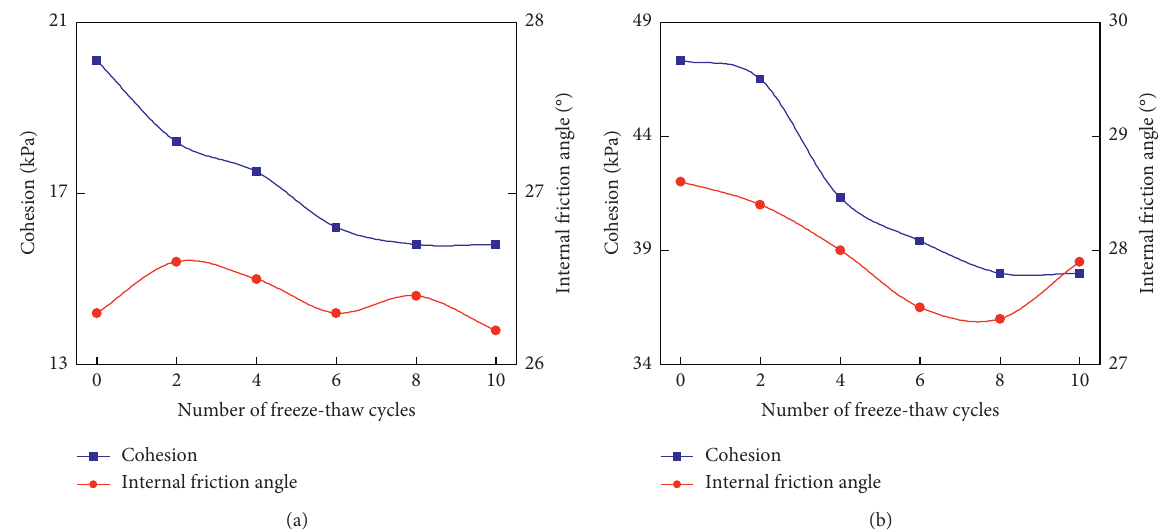
Figure 6: The effects of F-T cycles on strength with the number of cycles: (a) control loess; (b) fiber-reinforced loess.